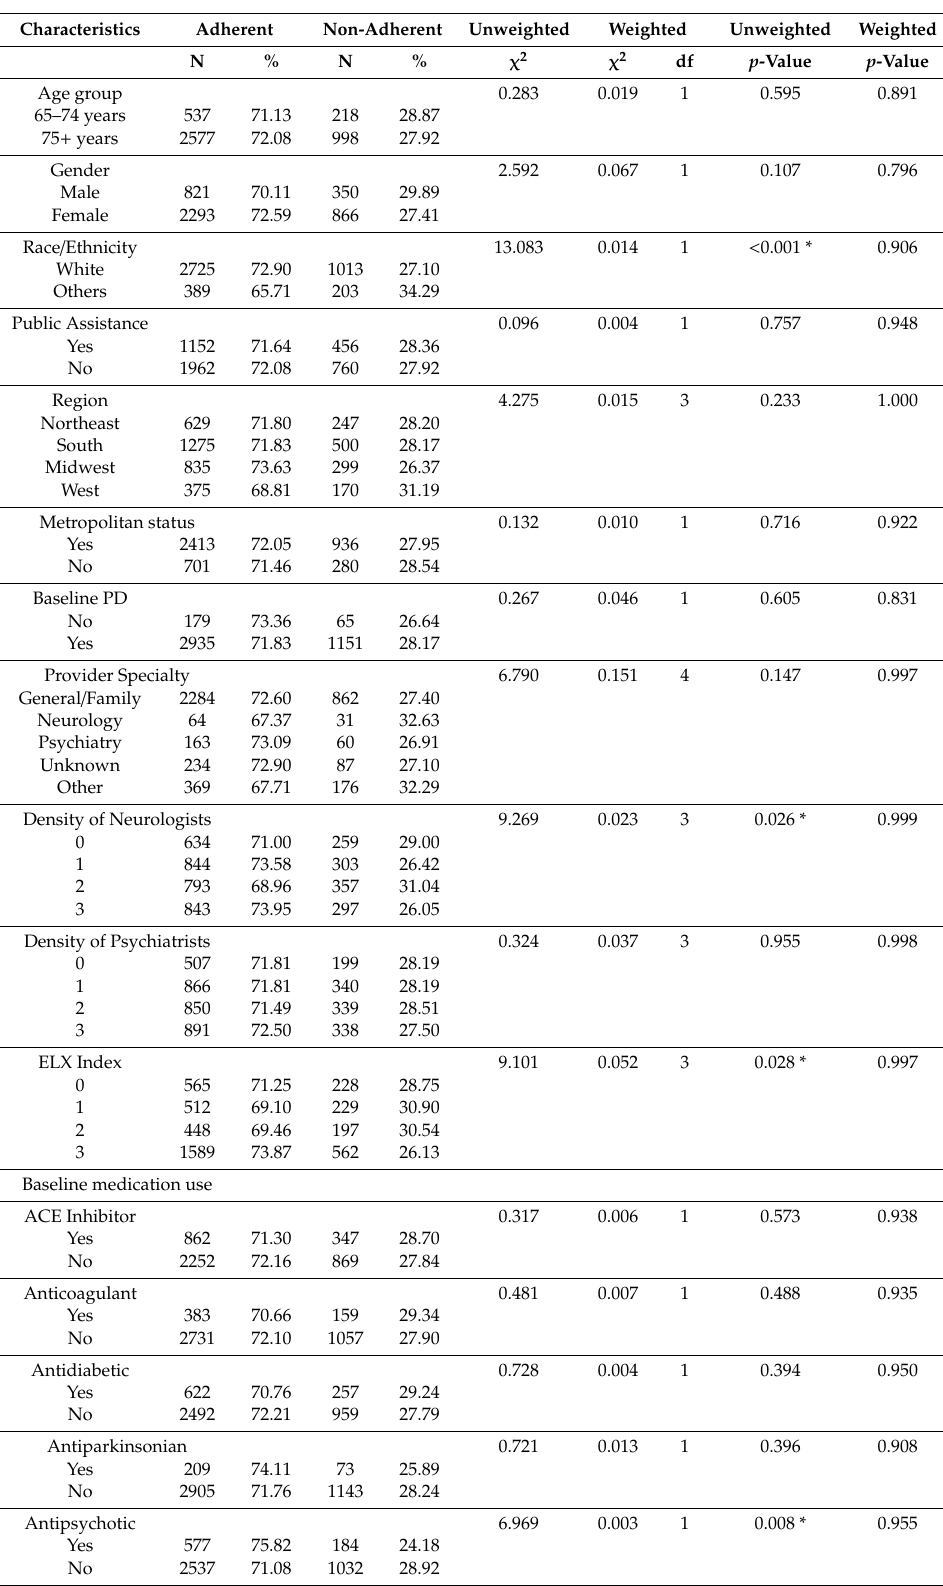
Table 1. Baseline characteristics of study sample included in the acute depression treatment